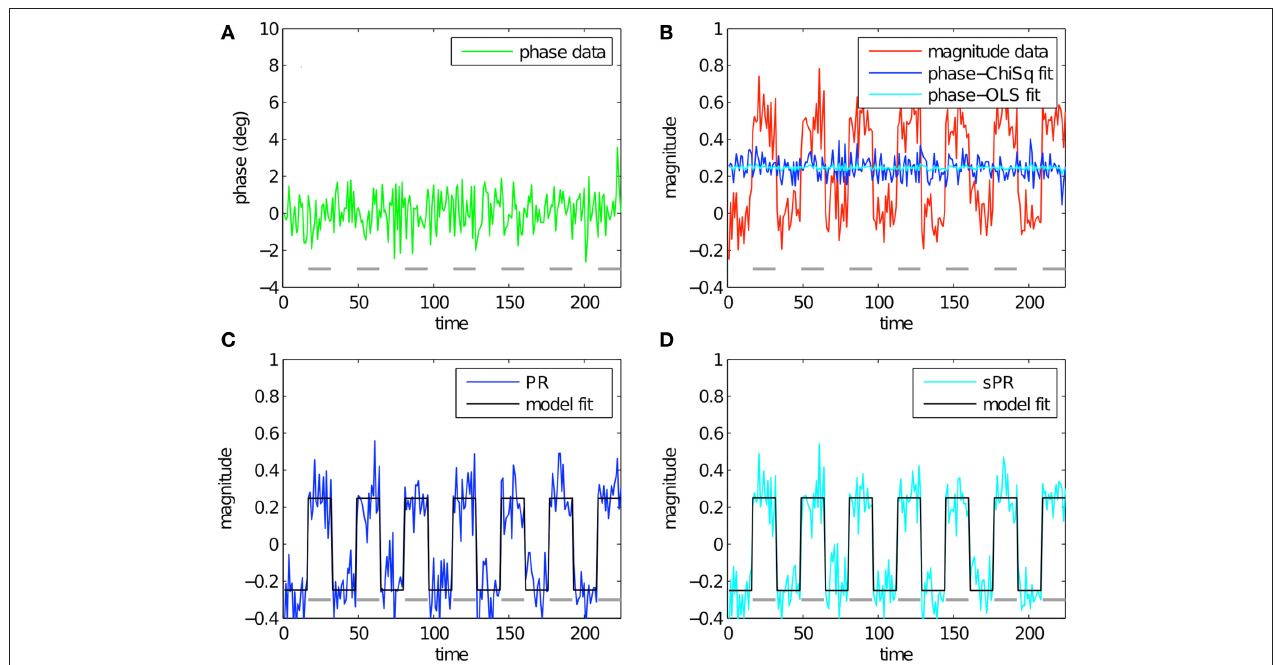
FIGURE 4 | Simulated large vein suppression in a voxel with no large vein contribution. In this regime, phase fSNR is low but magnitude fSNR is high. (A) Phase timecourse is plotted in green ( t = − 0.10). Gray dashes indicate stimulus-on periods. (B) Magnitude timecourse is plotted in red ( t = 5.21 ). Linear fits of phase to magnitude using L ChiSq and L OLS are plotted in blue and cyan, respectively. Using L ChiSq yields larger absolute fits (e.g., larger b * 1 values). (C) PR large vein suppressed timecourse is plotted in blue ( t = 4.38 ). PR model fit timecourse is plotted in black. (D) sPR large vein suppressed timecourse is plotted in cyan ( t = 5.16 ). sPR model fit timecourse is plotted in black. In this regime, both PR and sPR show good preservation of magnitude BOLD activity. sPR exhibits slightly better preservation than PR.